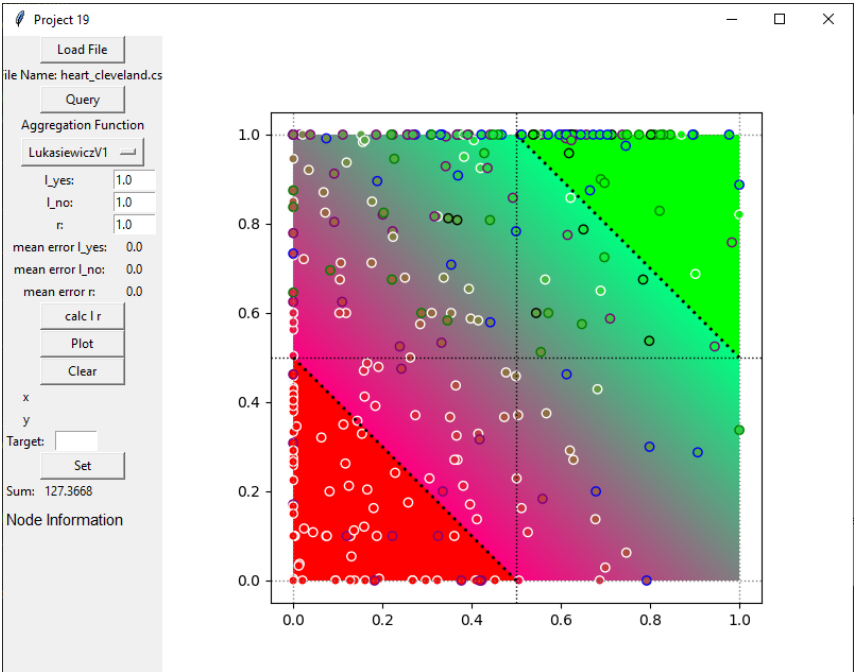
Figure 15. Visualisation of the Cleveland Heart Disease dataset in the classification space before adjusting λ and r